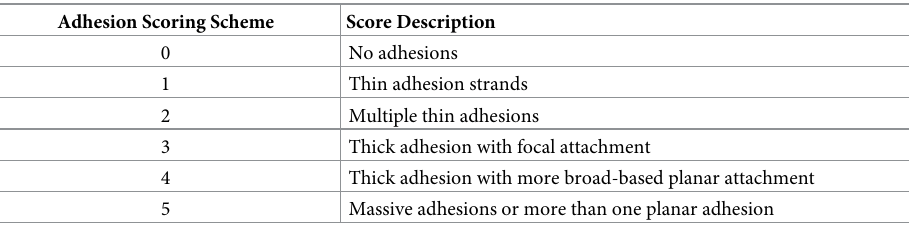
Table 1. Adhesion scoring